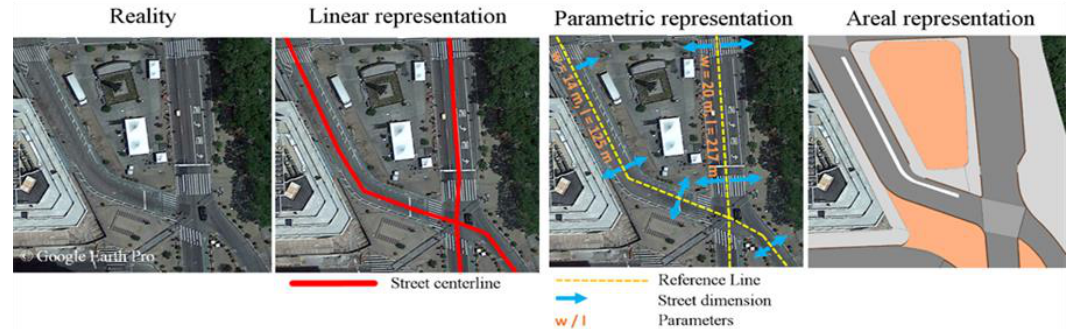
Figure 1. Comparison of different representation types for streetspace modelling [3].